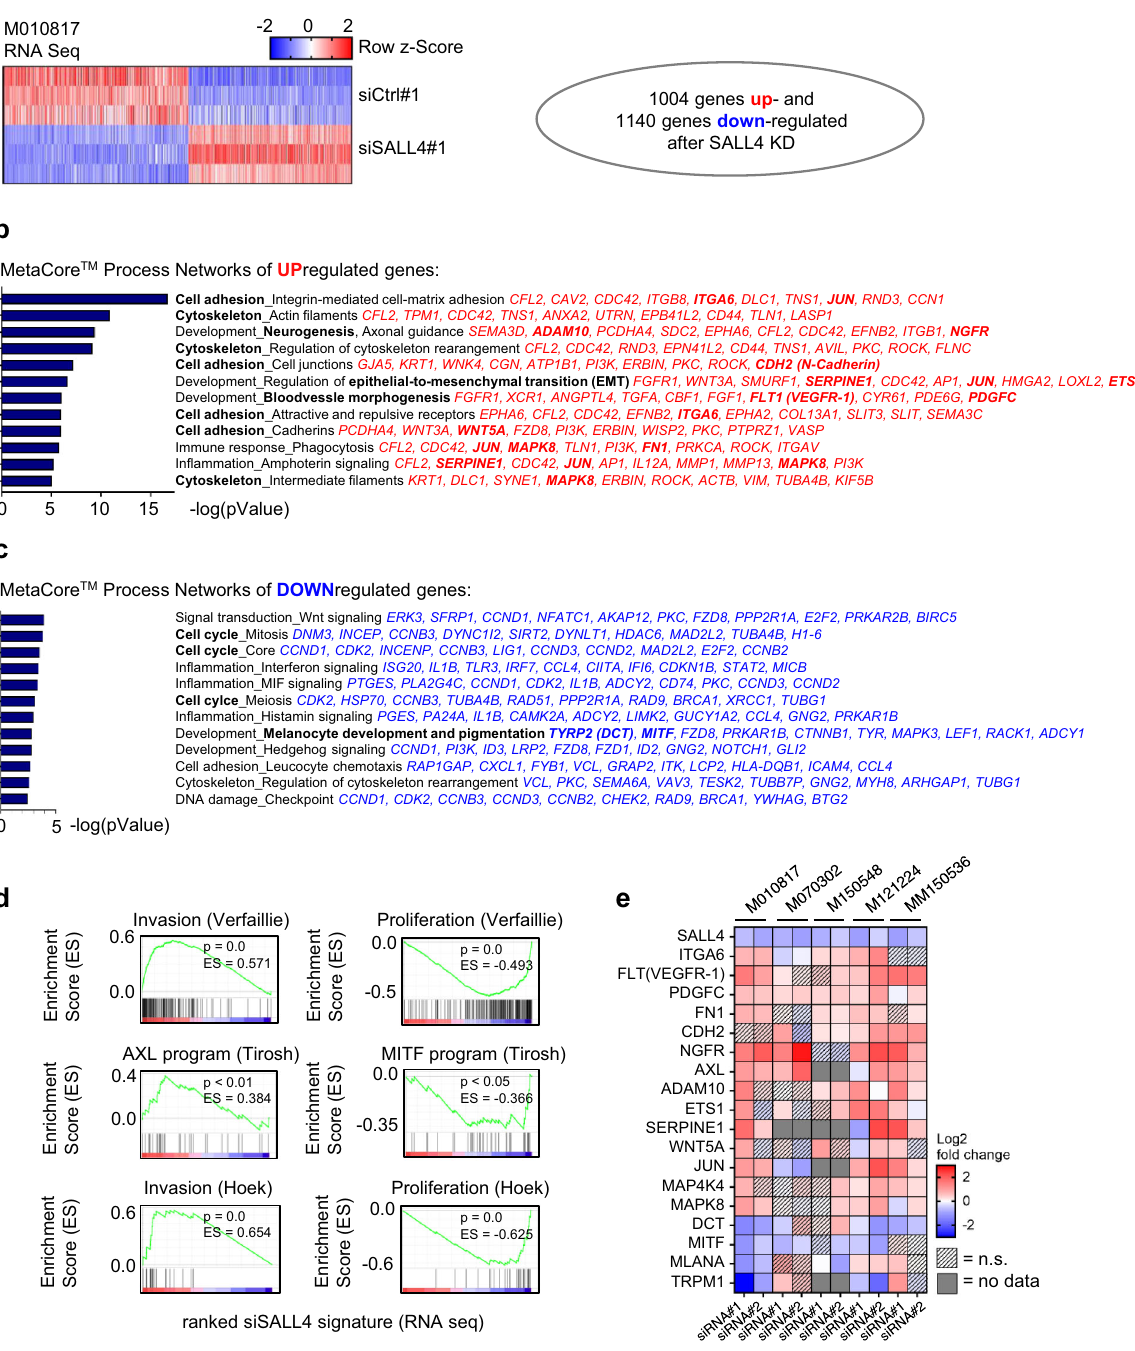
Fig. 4 RNA sequencing of SALL4 knockdown reveals an invasiveness gene expression signature. a RNA seq row z-score heatmap of differentially expressed (DE) genes after 48 h SALL4 knockdown in the human cell line M010817. Cutoffs were set at Log2 ratio ≥ 0.27 or ≤ − 0.27, p value < 0.05 and FDR < 0.05 and resulted in 1004 genes signi fi cantly upregulated and 1140 genes signi fi cantly downregulated. b Top 12 MetaCore TM process networks of upregulated genes. Top ten most upregulated genes per process are listed and genes validated in additional cell lines are highlighted in bold. c Top 12 MetaCore TM process networks of downregulated genes. Top ten most downregulated genes per process are listed and genes validated in additional cell lines are highlighted in bold. d Gene Set Enrichment Analysis (GSEA) of DE genes after SALL4 knockdown (log2 ratio-ranked) as in a with published genesets characterizing invasive versus proliferative melanoma cells 40 – 42 . e Log2 expression ratio heatmap of qRT-PCR-based gene expression analysis of speci fi c genes of interest (normalized to PPIA and set relative to siCtrl-treated cells) in human melanoma cell lines (M010817: NRAS Q61K ; M070302: unknown mutational status; M150548: BRAF V600E ; M121224: NRAS Q61K and BRAF V600E ; MM150536: BRAF V600E ) after 48 h treatment with two different siRNAs targeting SALL4. Two-sided t -tests were performed with N = 3 and p values ≥ 0.05 = n.s. Source data for e are provided as a Source Data fi